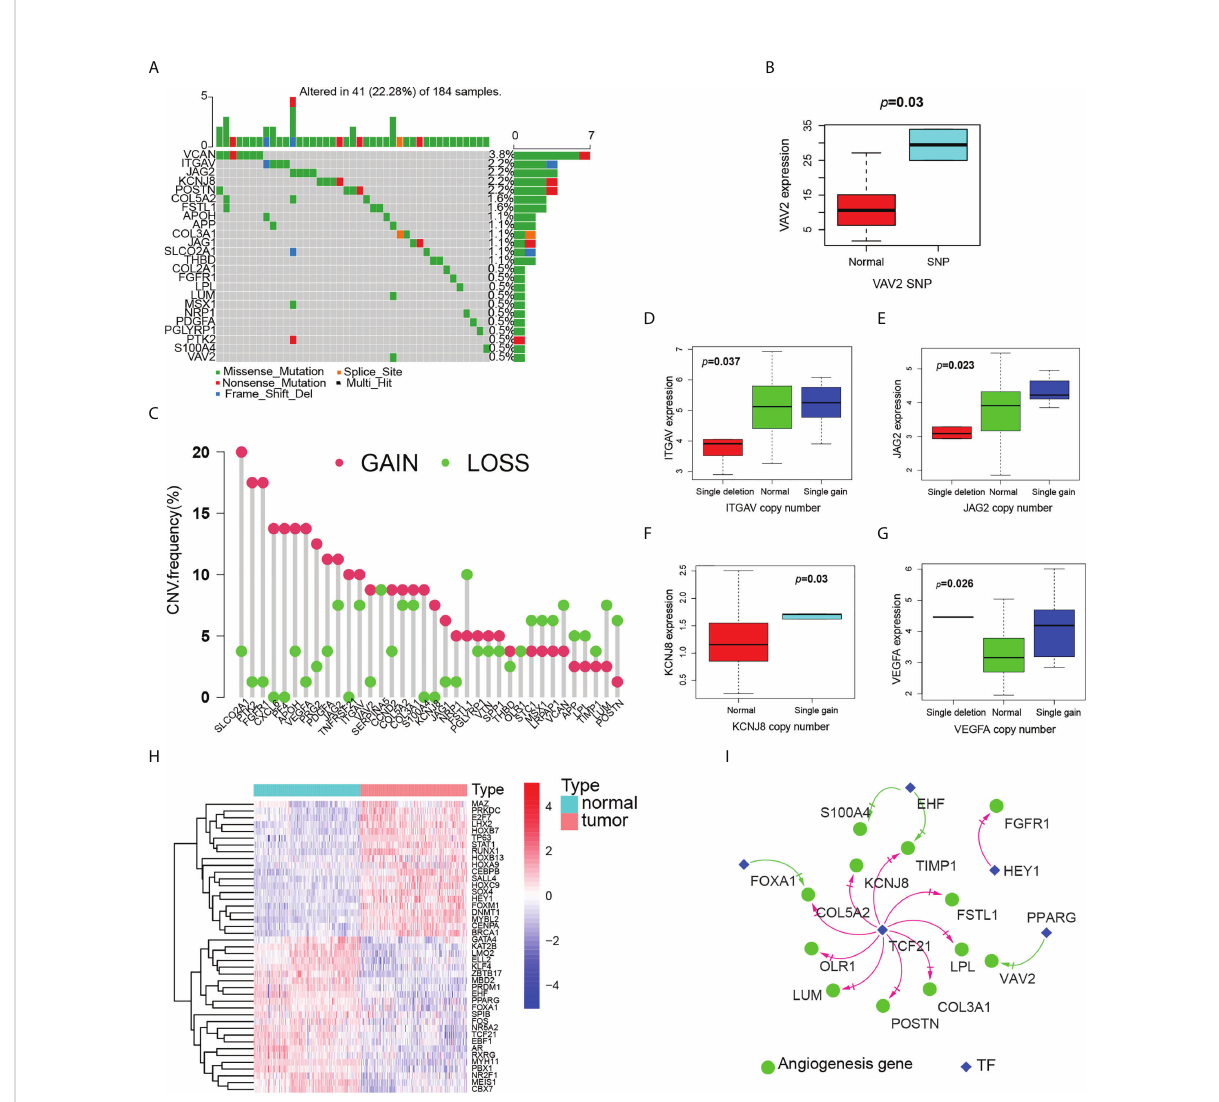
FIGURE 4 Multiomics analysis of angiogenesis genes. (A) Landscape of mutation of angiogenesis genes in ESCC patients. (B) Boxplot of the relationship between VAV2 expression and SNP. (C) Landscape of CNV of angiogenesis genes in ESCC patients. (D – G) Boxplot of the relationship between expression of angiogenesis genes and CNV, D(ITGAV), E(JAG2), F(KCNJ8),G(VEGFA). (H) Heatmap (blue: low expression level; red: high expression level) of the TF with p < 0.05 between the normal and the tumor tissues. (I) The correlation network of expression between angiogenesis genes and TF. (red line: positive correlation; blue line: negative